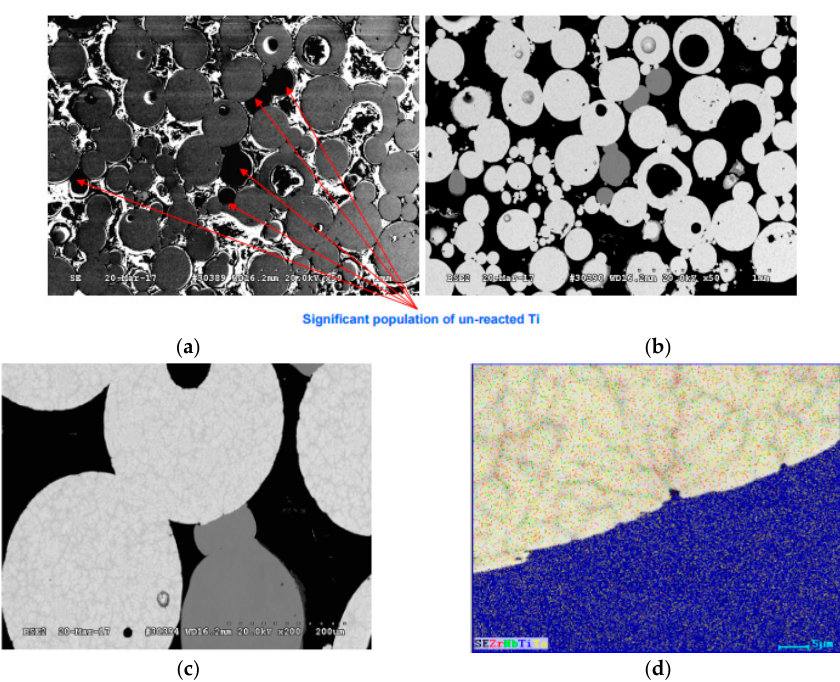
Figure 4. SEM ( a - c ) and EDS ( d ) analysis of TNZT sample sintered at 400 °C with 60 MPa and 15 min of holding time that shows 68% of relative density and contains unreacted titanium. In the map shown in ( d ), the Red refers to Zr, Green to Nb, Blue to Ti, and Yellow to Ta.